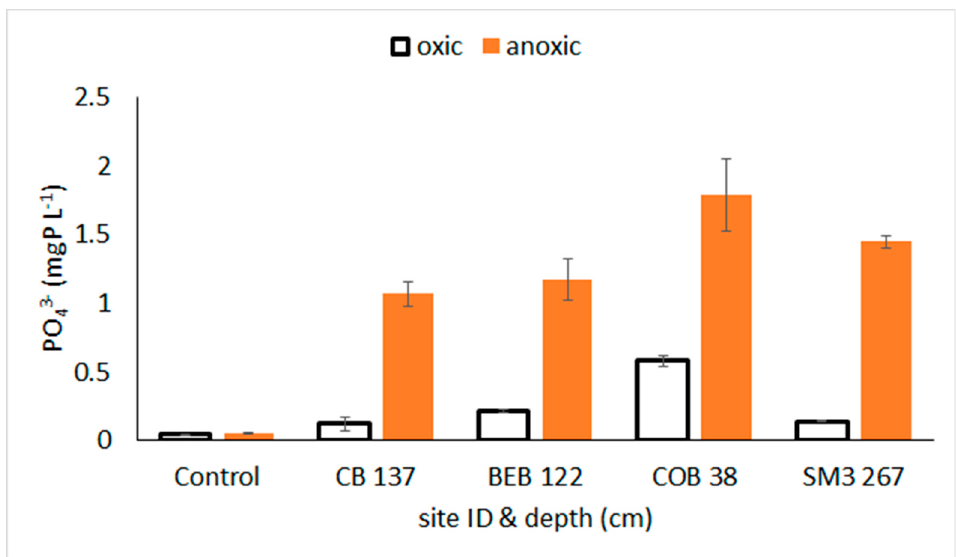
Figure 4 : Comparison of sediment EPC 0 values for four depths for stream bank site BEB against stream water PO 43 − concentrations over the period August 2017 to July 2018. Sediment sampling was done only one time in October–November 2017. EPC 0 values for four depths 60, 122, 183, and 260 cm from the top were 0.032, 0.028, 0.002, and 0.032, respectively.